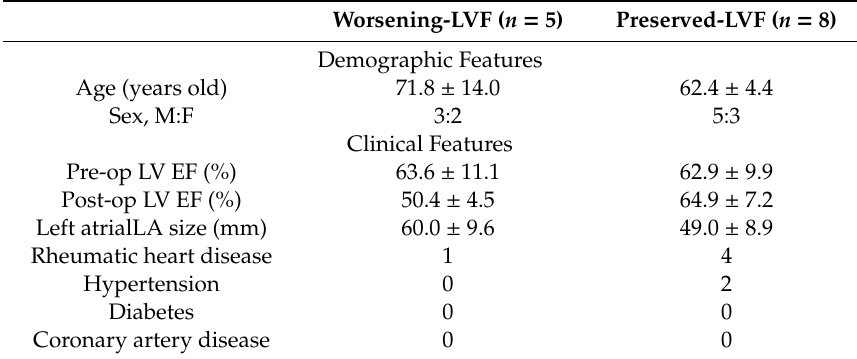
Table 1. Demographic and clinical features of patients after maze procedure.